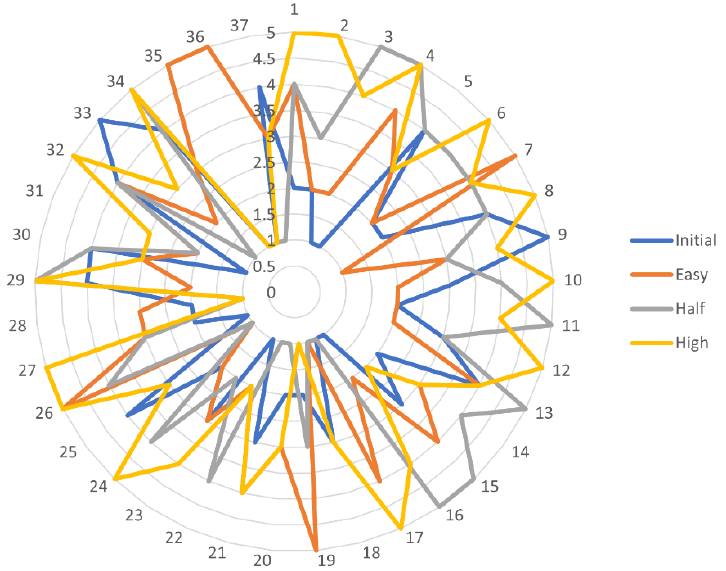
Figure 7. Dashboard of scores obtained during the CTF by participant and activity.